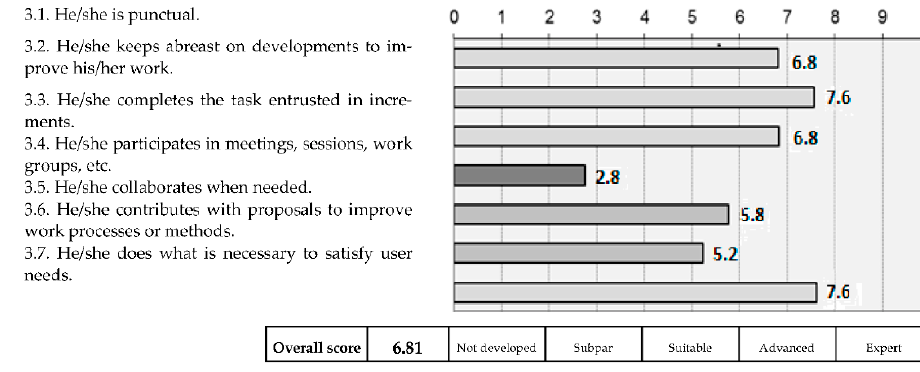
Figure 1. Example of an individual feedback report (Commitment-Engagement competency).